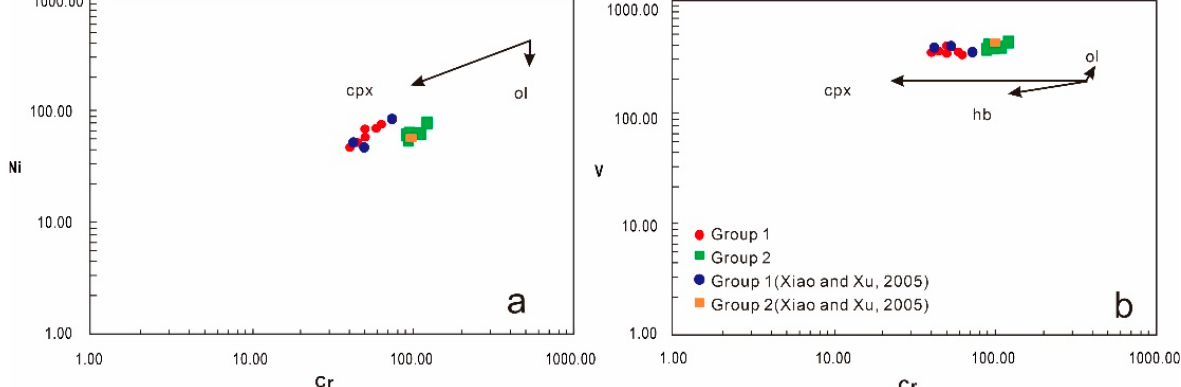
Figure 9. ( a ) Cr vs. Ni diagram; ( b ) Cr vs. V diagram [64].